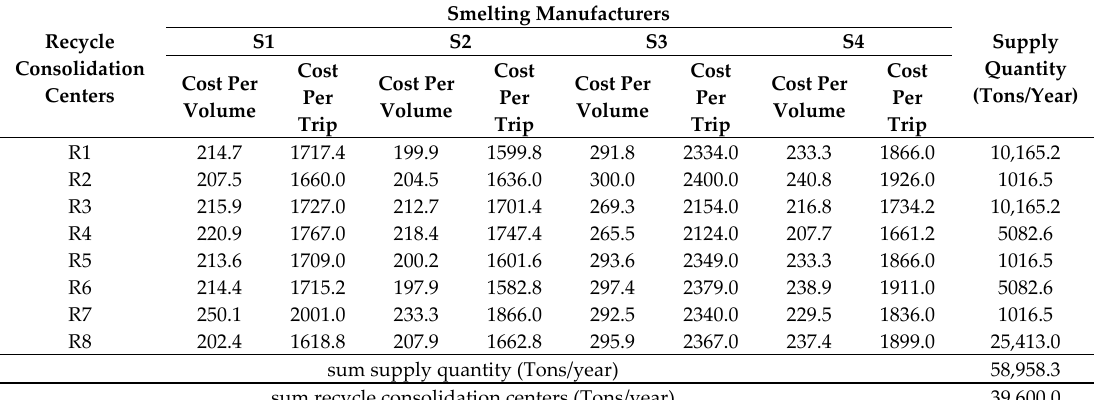
Table 1. The information of capacity, supply quantity and cost